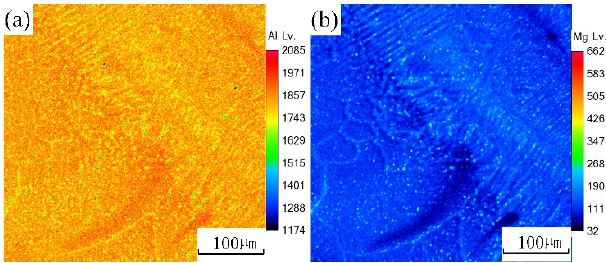
Figure 12. The sweep diagrams of different elements in the underwater cladding layer: ( a ) Al; ( b ) Mg.